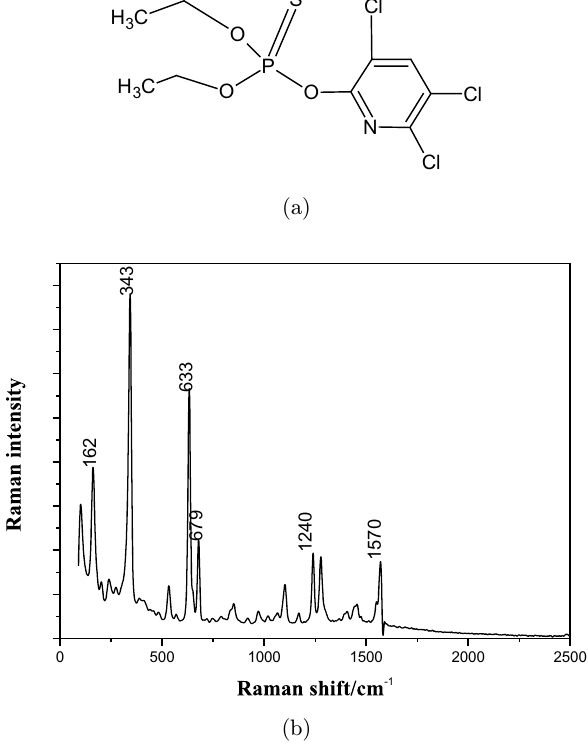
Fig. 1. (a) Chemical Structure of Chlorpyrifos; (b) Raman spectra of Chlorpyrifos